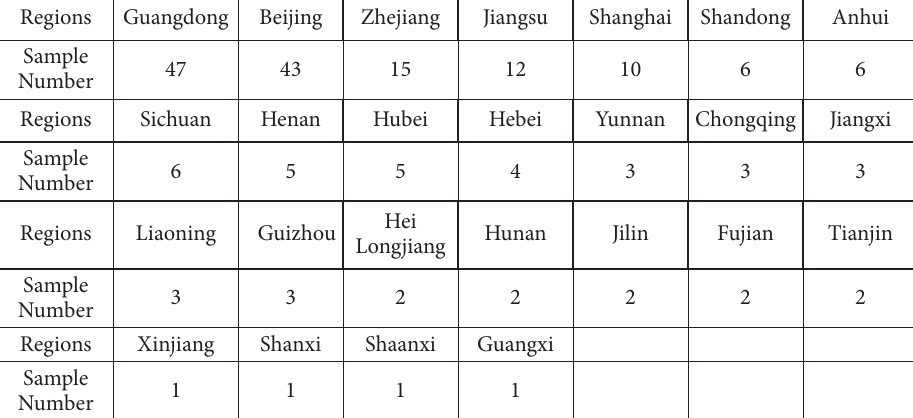
Table 6. Region distribution of sample